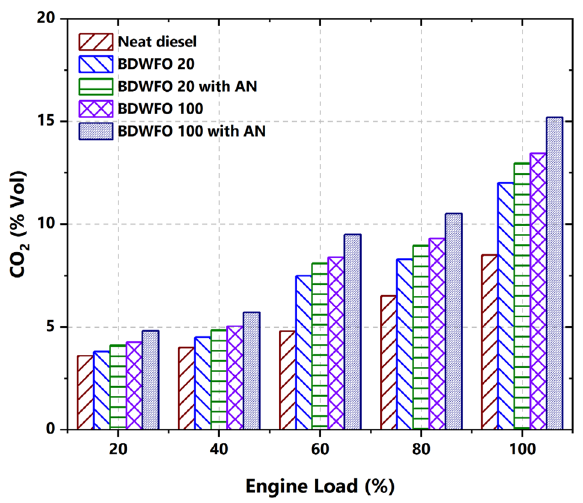
Figure 11. Emission of carbon dioxide—CO 2 (%) versus variation on load